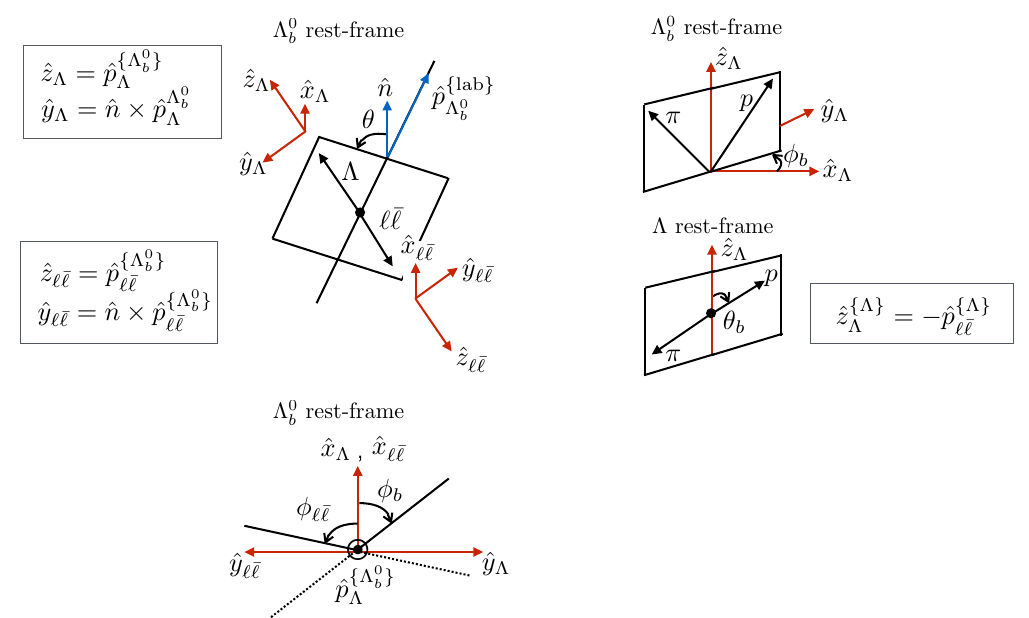
+ ‘ Figure 1 . The (cid:3) (cid:0) decay is described by (cid:12)ve angles: the angle, (cid:18) , between the direction b ! (cid:3) ‘ of the (cid:3) baryon and the normal vector ^ n in the (cid:3) b rest-frame; and two sets of helicity angles, describing the decays of the (cid:3) baryon ( (cid:18) b ; (cid:30) b ) and the dilepton system ( (cid:18) l ; (cid:30) l ). For